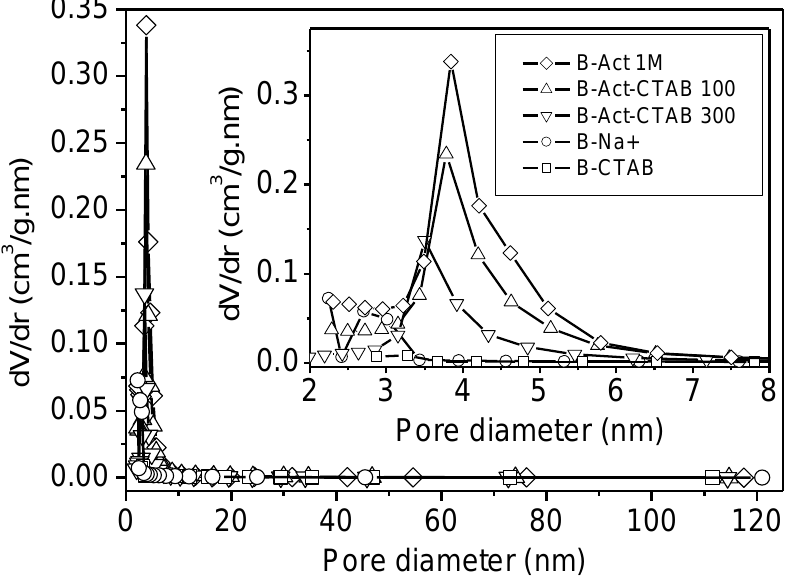
Figure 5. Pore Size Distribution (PSD) models of studied clay samples.